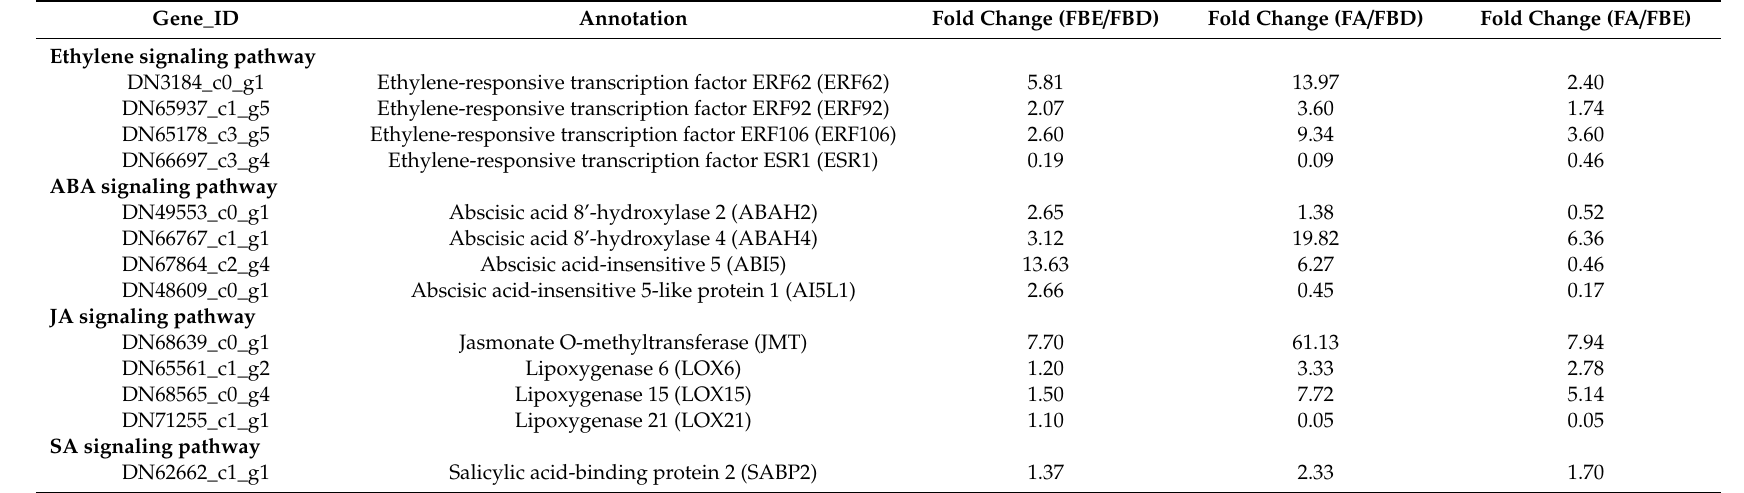
Table 2. DEGs involved in the ethylene-, ABA-, JA-, and SA-signaling